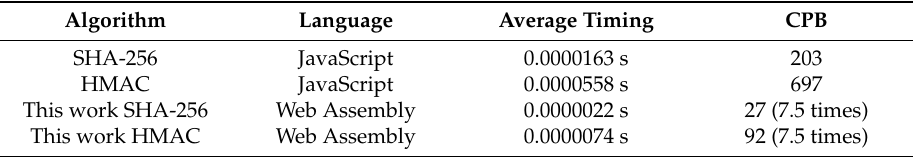
Table 16. HMAC algorithm performance in Chrome ( CPB : Cycle Per